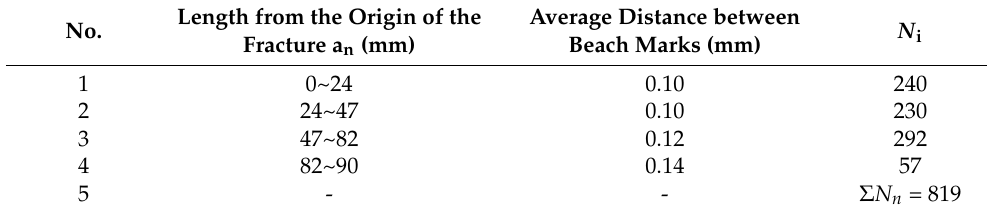
Table 4. Data relating to fatigue beach mark spacing at the boom break. Length from the Origin of the No. Fracture a n (mm)